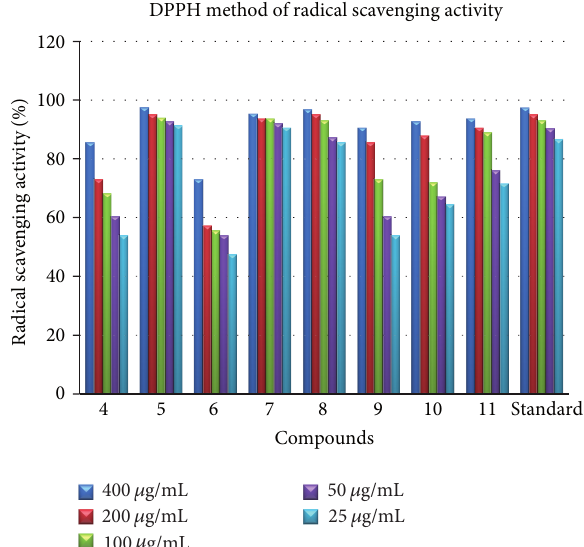
F 3: Pancreatic lipase inhibitory activity of compounds 4–11 .